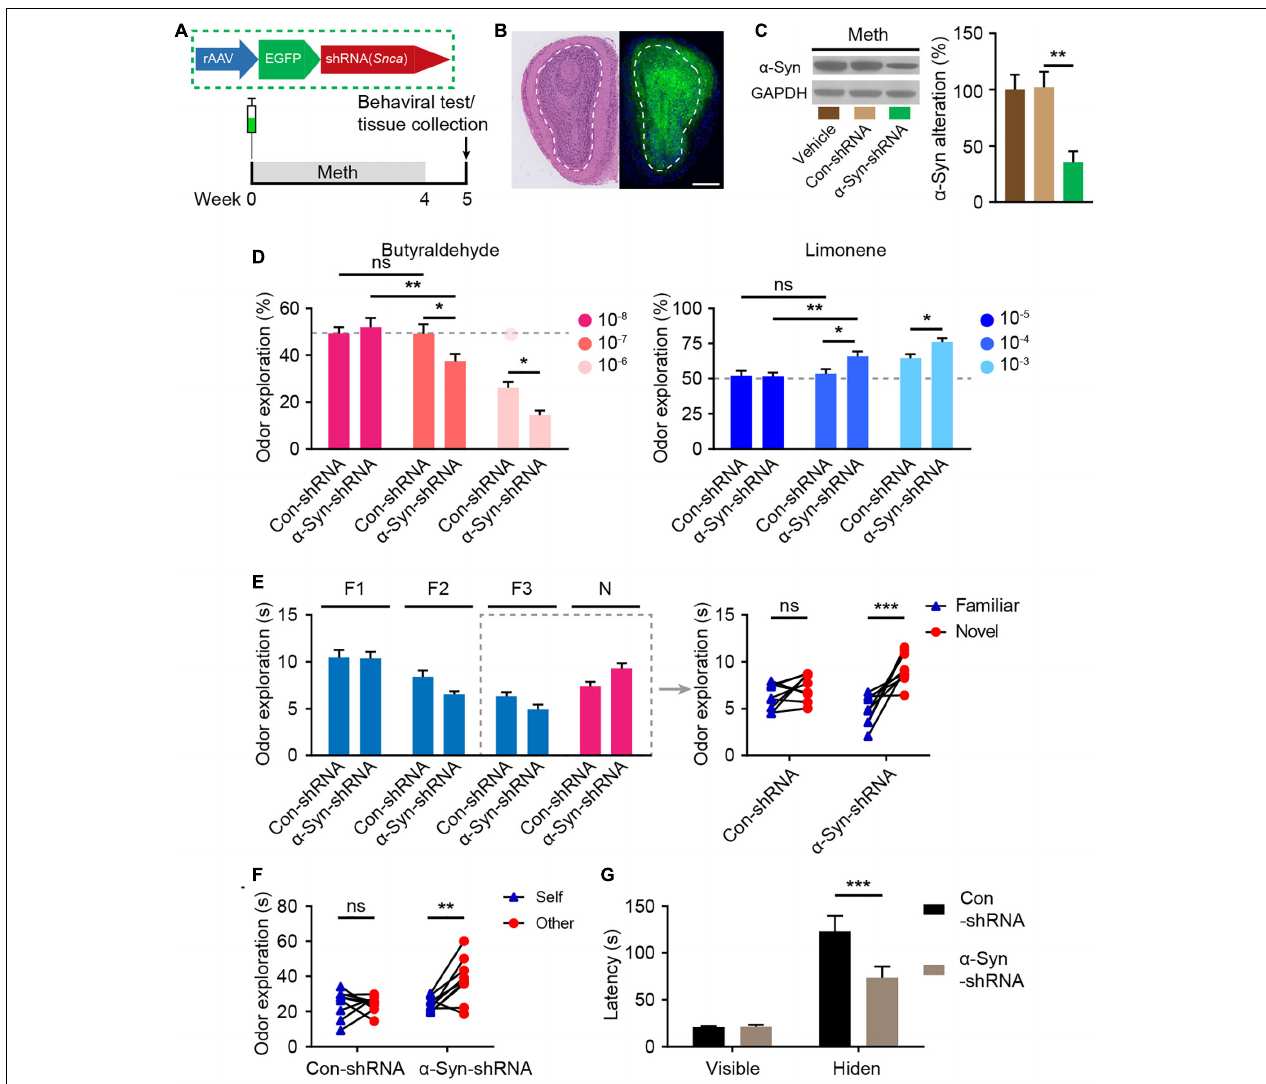
FIGURE 4 | Suppression of α -syn rescues methamphetamine-induced olfactory behavioral abnormalities. (A) Experimental scheme for injection of reconstructed adeno-associated virus (rAAV) containing α -syn-shRNA or control into the olfactory bulb and subsequent behavioral testing. (B) Schematic representation of the rAAV injection strategy and representative HE staining and immunofluorescence images of olfactory bulb sections of rAAV-injected mice ( n = 3). Scale bar, 500 µ m. (C) The efficiency of α -syn-shRNA was determined by western blot analysis ( n = 6). F = 9.371, P = 0.0023 by One-way ANOVA with Bonferroni’s multiple comparisons test. (D) Suppression of α -syn increased olfactory sensitivity to both aversive (butyraldehyde) and favorite (Limonene) odors ( n = 9). Butyraldehyde: F ( 2 , 32 ) = 3.383, P = 0.0465 by two-way RM ANOVA with Bonferroni’s multiple comparisons test. Limonene: F ( 2 , 32 ) = 2.926, P = 0.0681 by two-way RM ANOVA with Bonferroni’s multiple comparisons test. (E) Suppression of α -syn improved olfactory discrimination ( n = 9). F ( 1 , 16 ) = 8.432, P = 0.0104 by two-way RM ANOVA. (F) Suppression of α -syn improved social olfactory discrimination. Each scatter dot represents an animal, and it was paired with the corresponding stranger ( n = 9). F ( 1 , 16 ) = 7.993, P = 0.0121 by two-way RM ANOVA. (G) Suppression of α -syn improved olfactory function to locate invisible food ( n = 9). F ( 1 , 16 ) = 6.669, P = 0.0200 by two-way RM ANOVA. F, familiar; N, novel; ns, not significant. Data are presented as mean ± SEM. * P < 0.05; ** P < 0.01; *** P <